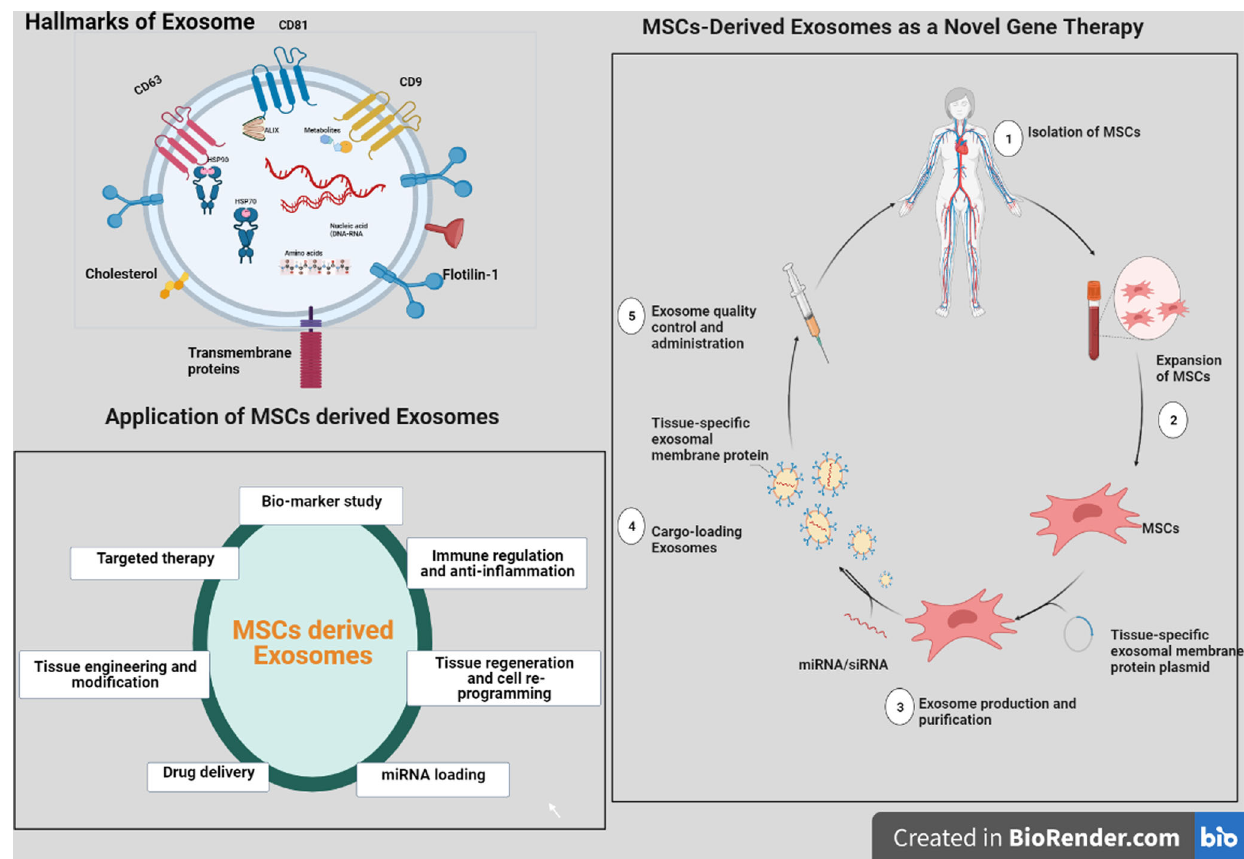
Fig. 3 Exosome characterization, isolation from MSC, and application as novel gene therapy. Exosomes are cell-secreted nanoparticles (30 – 150 nm in size) containing various biological components, including nucleic acids, proteins, and lipids, which play crucial roles in intercellular communication. As carriers, exosomes offer promise as enhanced platforms for targeted gene delivery due to their unique features, including intrinsic stability, minimal immunogenicity, and exceptional tissue/cell penetration potential. Targeted delivery raises the local concentration of therapeutics while minimizing negative